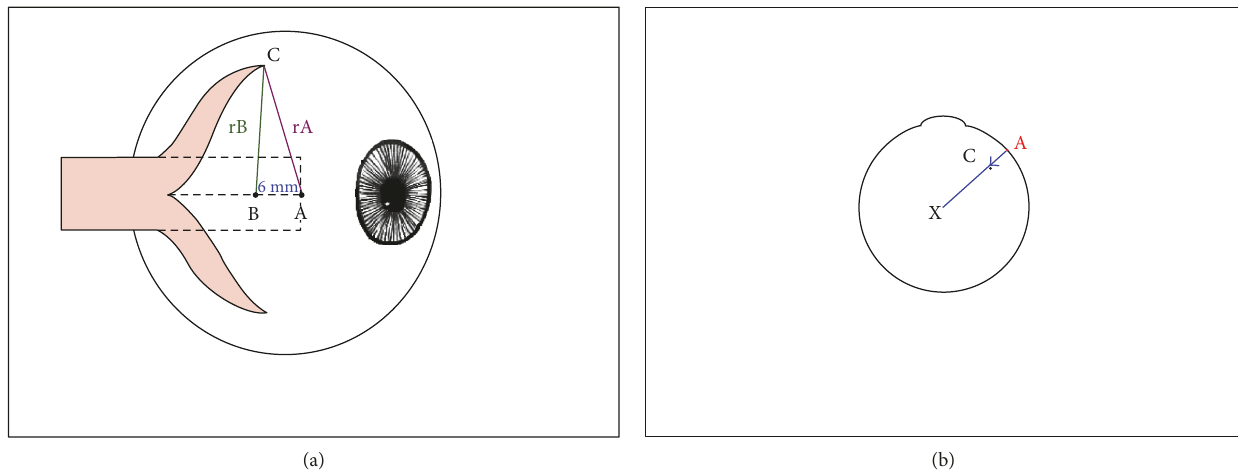
Figure 1: Schematic representation of the Y-splitting procedure of the medial rectus muscle. (a) Side view. (A) point at the middle of the original insertion (dotted line) of the medial rectus muscle. (B) point 6 mm distal of point A. (rA, rB) radius of predetermined distances (see text). Calipers are centered on point A, and a circle is drawn on the sclera with rA; then, the calipers are centered on point B, and a circle with rB is marked on the sclera. The intersection of the circles marks point C, the point of scleral re fi xation. In this graph, measurements are shown for reattachment of the superior muscle section; the same is applied to the lower half. (b) View of the eye from above. Reattaching the split medial rectus to point C (shown for the superior half) reduces the lever arm (the distance between the center of the globe and the insertion of the muscle), and thus the